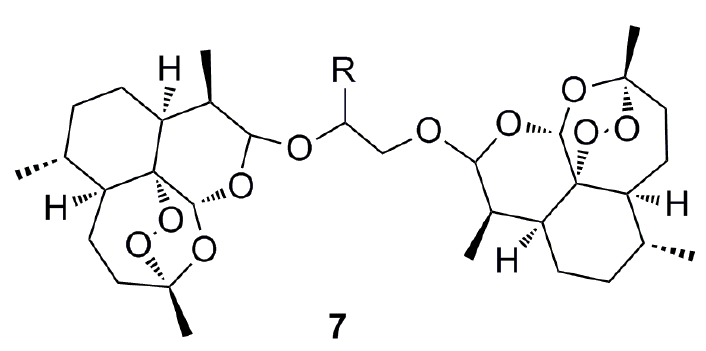
Figure 5. artemisinin dimer 7